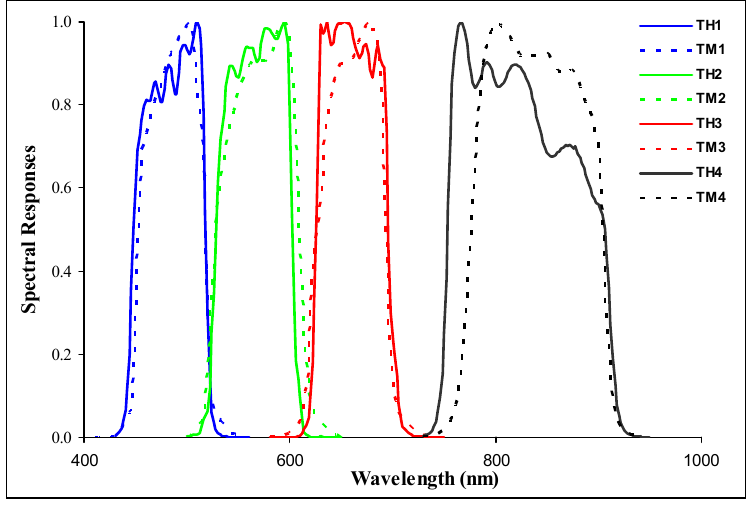
Figure 3. Spectral responses of the THEOS and Landsat 5 TM multi-spectral sensors Source: Geo-Informatics and Space Technology Development Agency (Public Organization) [11]; European Space Agency (ESA)